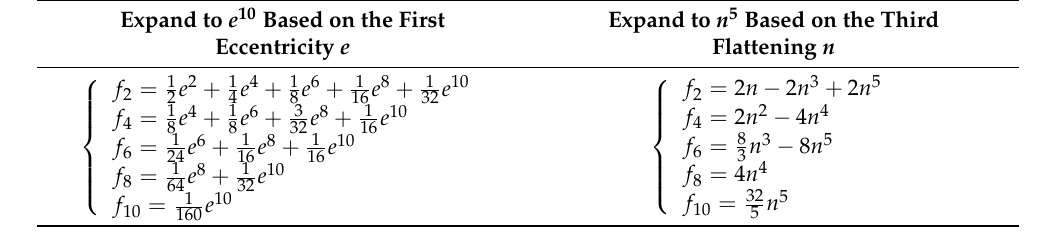
Table 10. Coefficients in Equation